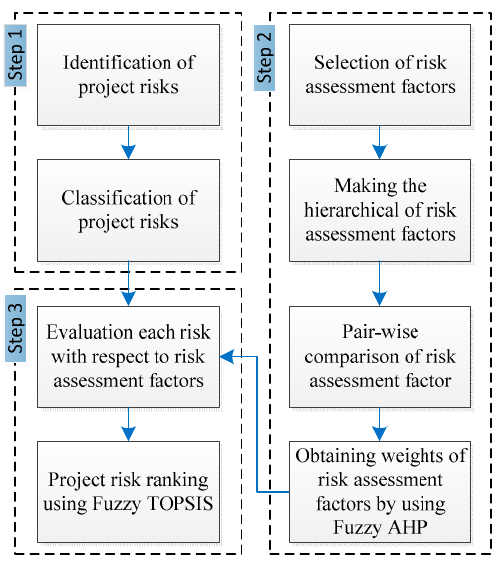
Figure 1. Flow chart of designed model. Source: Authors’ elaboration.